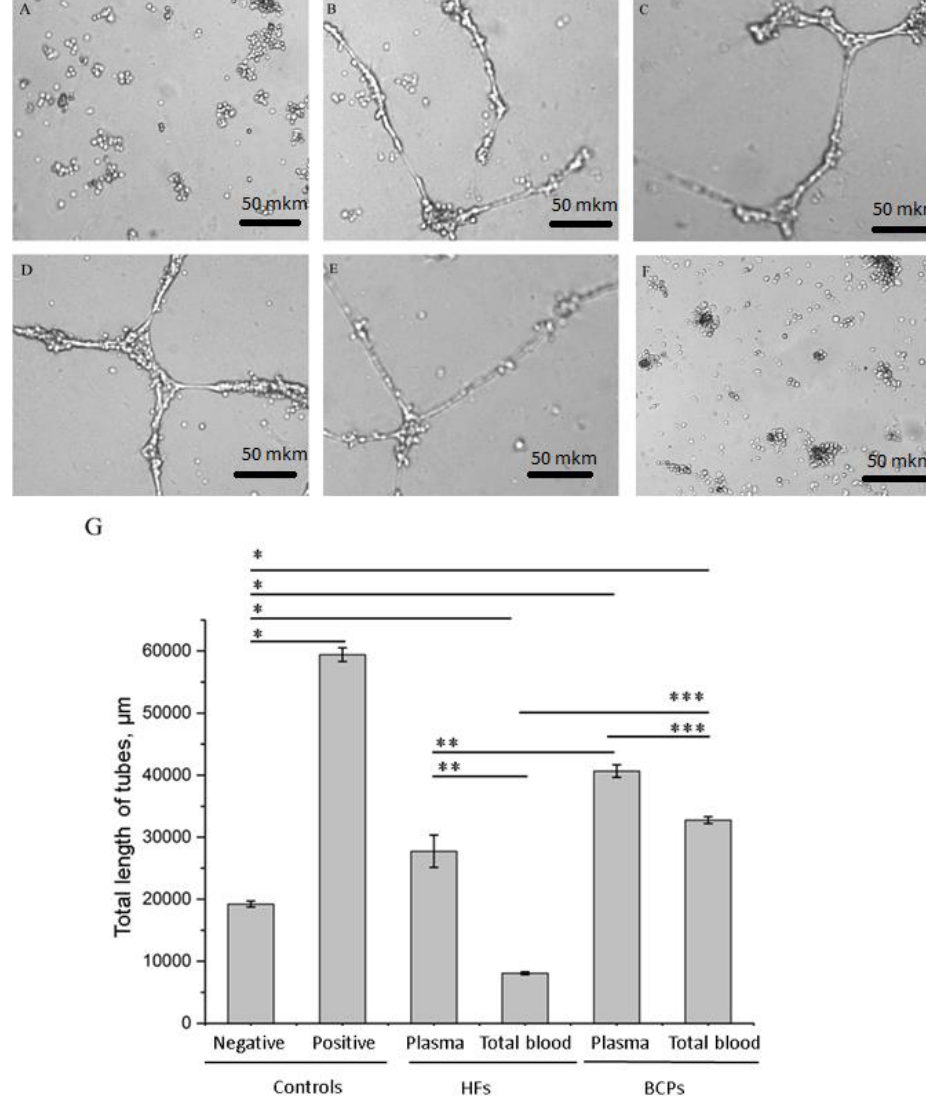
0.0206 and p = 0.0439, respectively) (Figure 3).